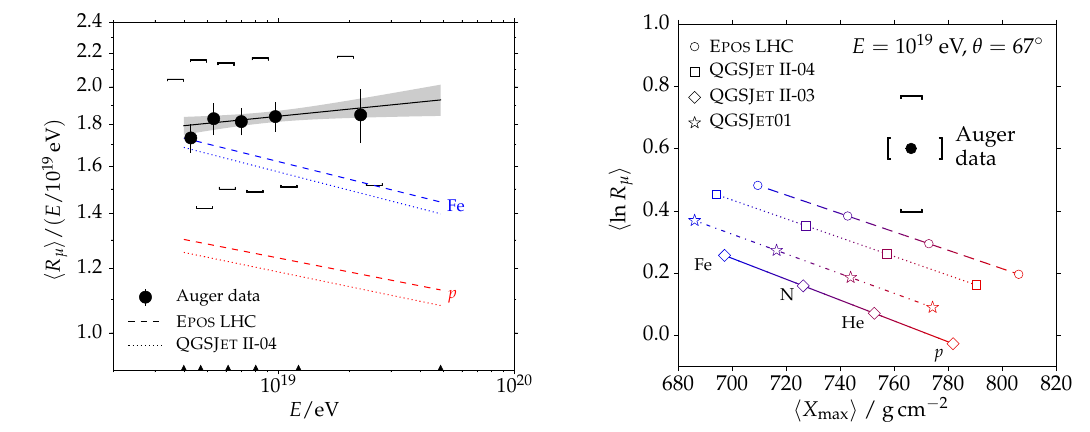
Figure 2. Results of the analysis of the muon content in highly inclined events [7].